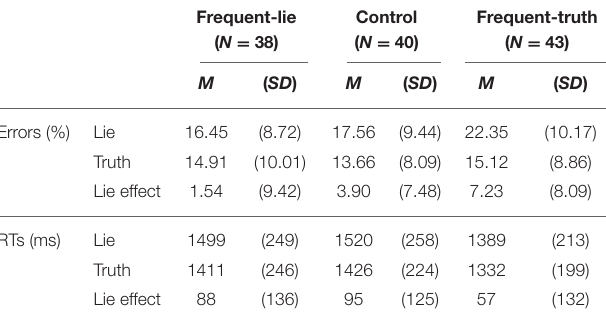
TABLE 1 | Errors and reaction times in Experiment